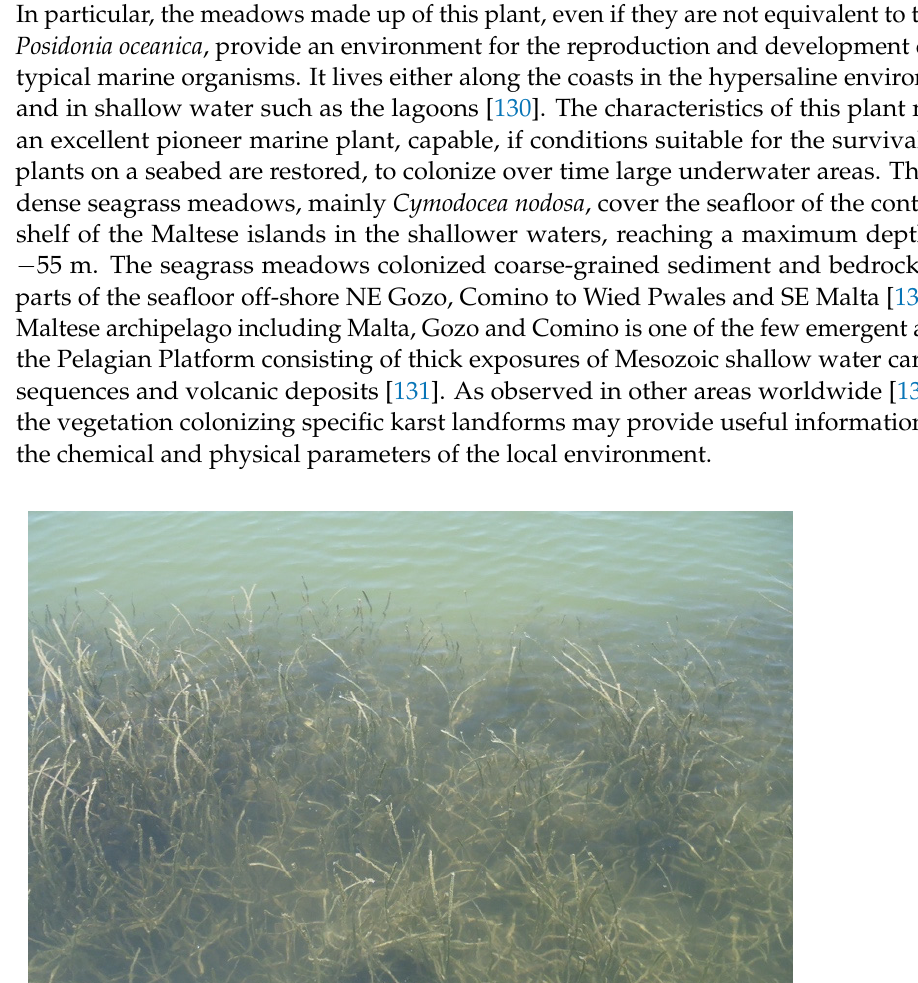
Figure 12. Detail of one of the sinkholes: the oars are located across the sinkhole rim, one outside it, and the other within the depression. The difference in elevation is about 0.7 m.